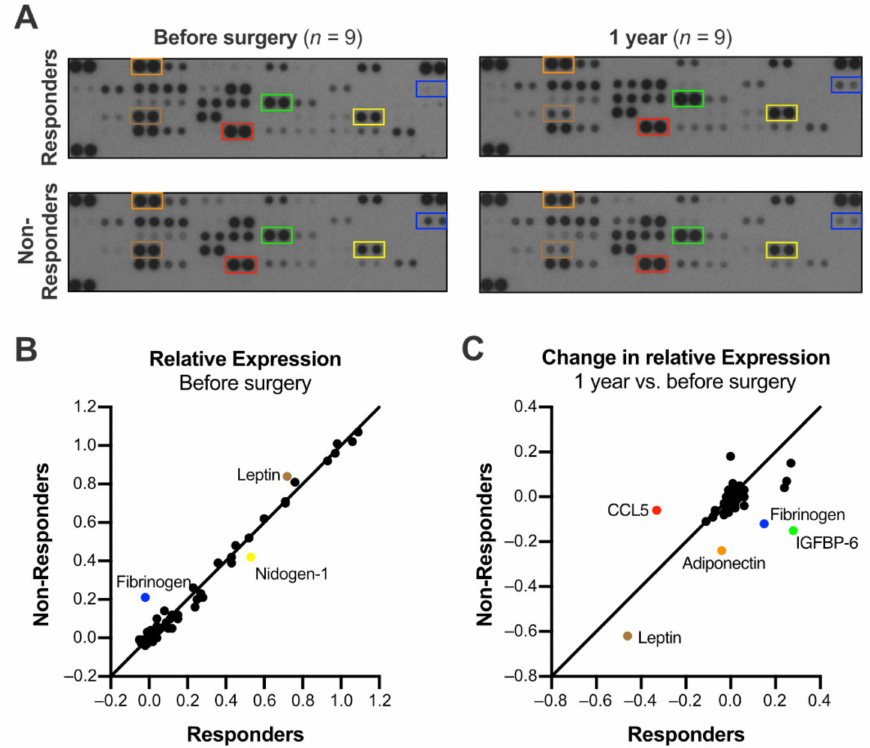
Figure 3. Distinct adipokine expression in responders and non-responders. ( A ) High resolution scans of the original arrays. Pooled serum samples of nine patients per group were subjected to adipokine arrays before and one year after surgery. ( B ) The analysis of the expression relative to positive control dots revealed a greater expression of fibrinogen and leptin in non-responders; nidogen-1 was less abundant in this group. ( C ) One year after surgery, fibrinogen and insulin-like growth factor binding protein 6 (IGFBP-6) expression increased in the response group but decreased in non- responders. Leptin also showed a greater decrease in non-responders. Adiponectin–unchanged in its expression in the response group–decreased by 23.9% in non-responders during the one-year follow up. Contrarily, CCL5 remained stable in non-responders but decreased in patients responding to the bariatric surgery. Correspondingly colored boxes in ( A ) label the protein’s positions on the